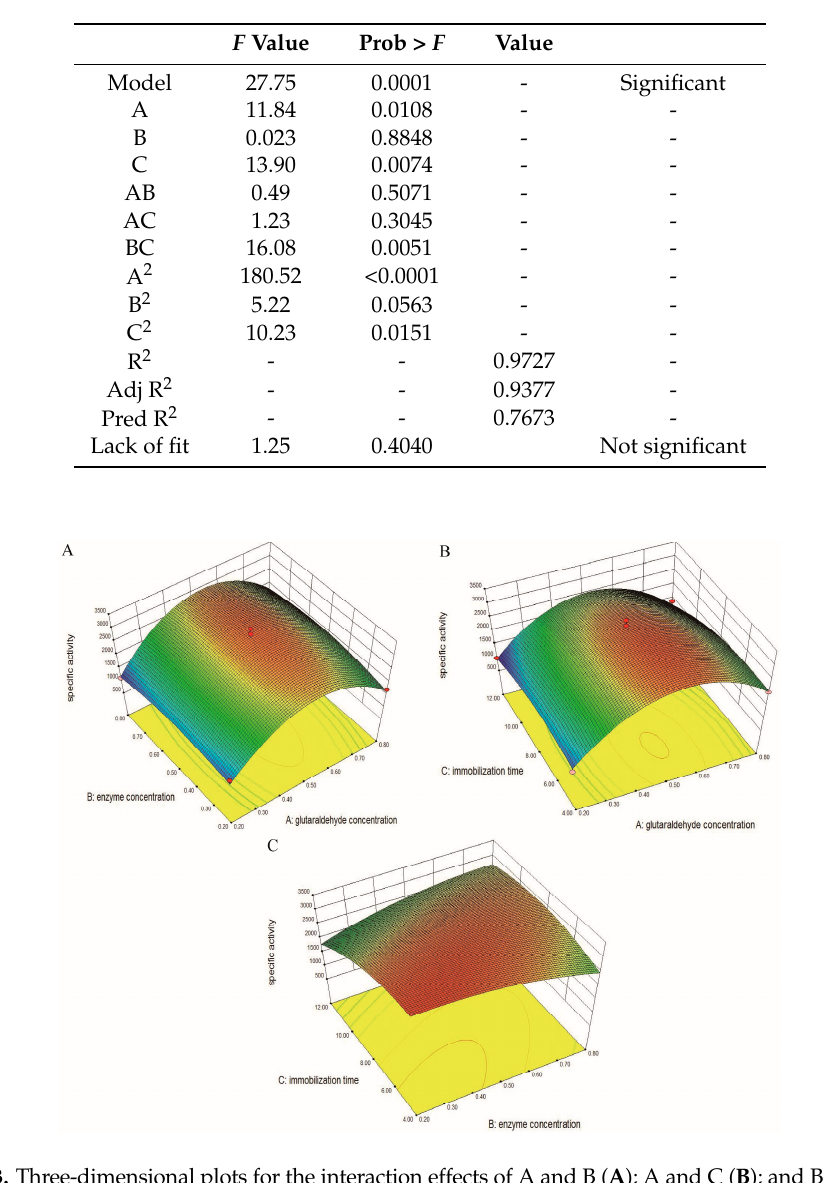
ANOVA of response surface methodology (RSM) variables for specific activity of